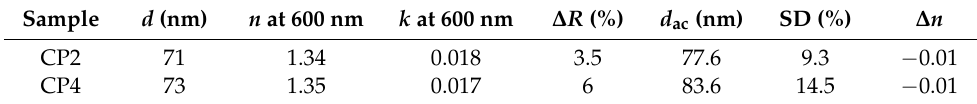
Table 3. Thickness, d, refractive index, n, extinction coefficient, k of CP2 and CP4 copolymer films, reflectance change ( ∆ R = |R ac − R ar | ) , thickness of the film exposed to acetone vapors, d ac , swelling degree, SD = ( d ac − d ar )/ d ar , and refractive index change ∆ n = n ac − n ar after exposure to acetone va- pors.